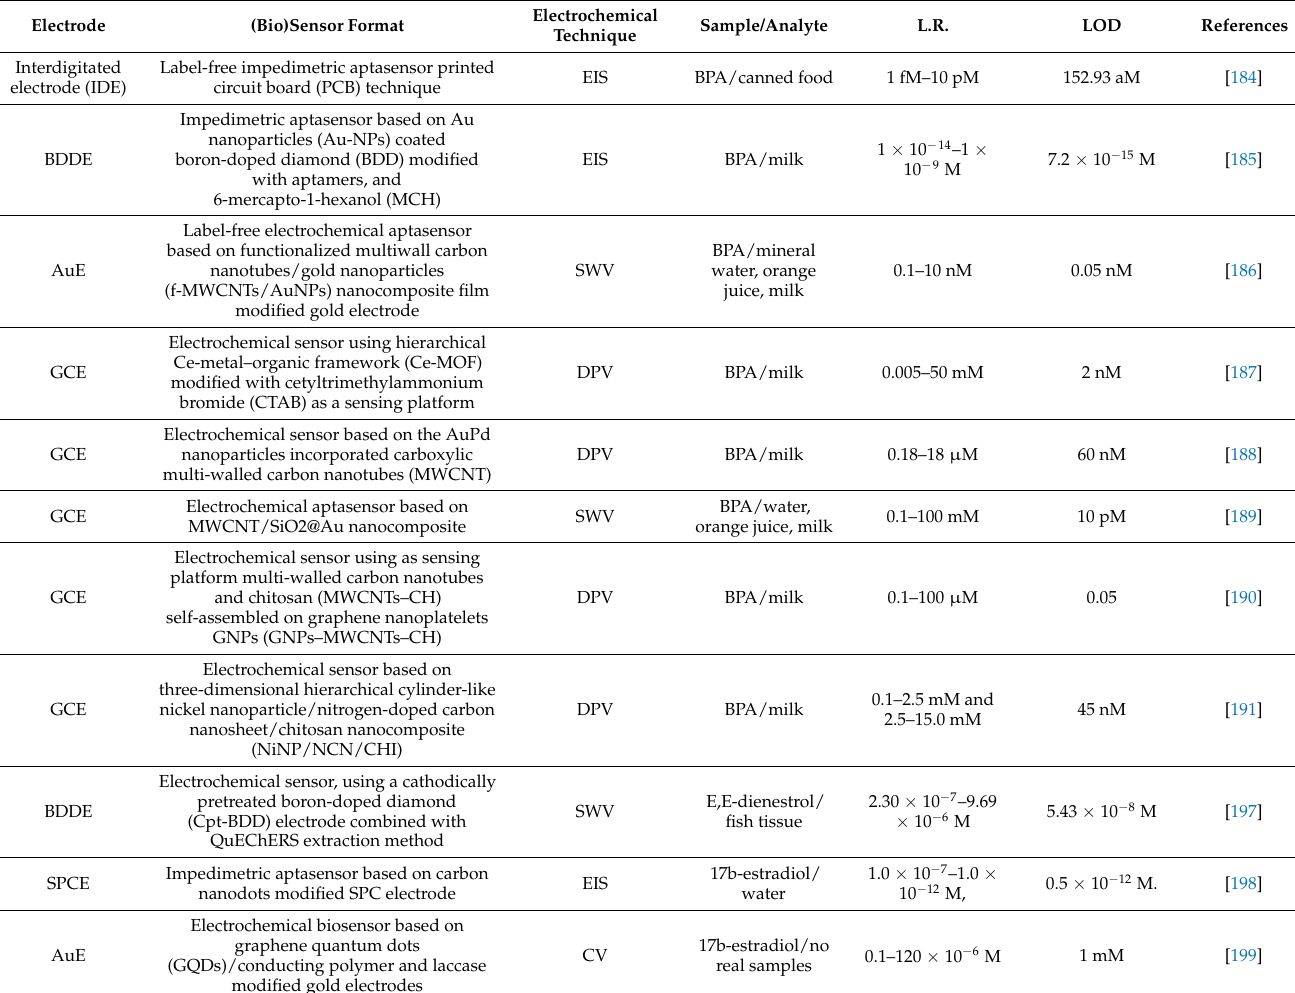
Table 5. An overview of recent electrochemical biosensors for BPA and estrogens determination. Electrode (Bio)Sensor